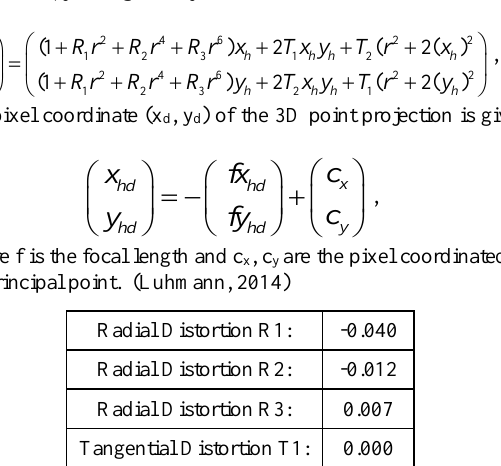
Table 1. Initial camera parameters of Canon S110 RGB Sensor Width [mm]: